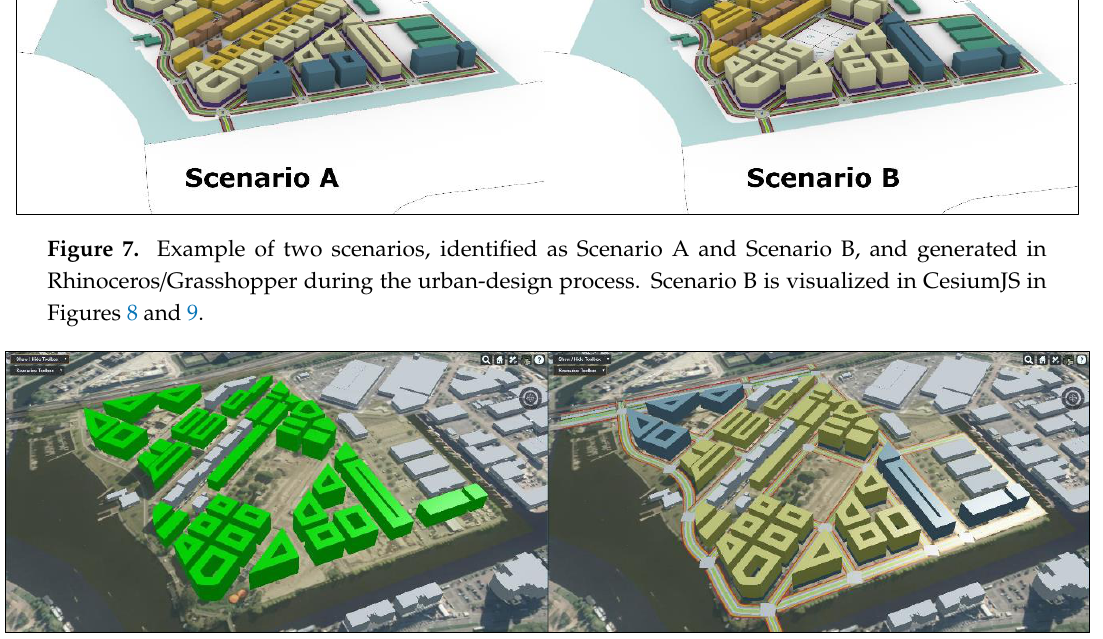
Figure 8. Example of the online scenario visualization interface: Scenario B of Figure 7 is presented here visualizing either the new buildings (in green) ( left ) or the new usage zones ( right ). Existing buildings are visualized in white.